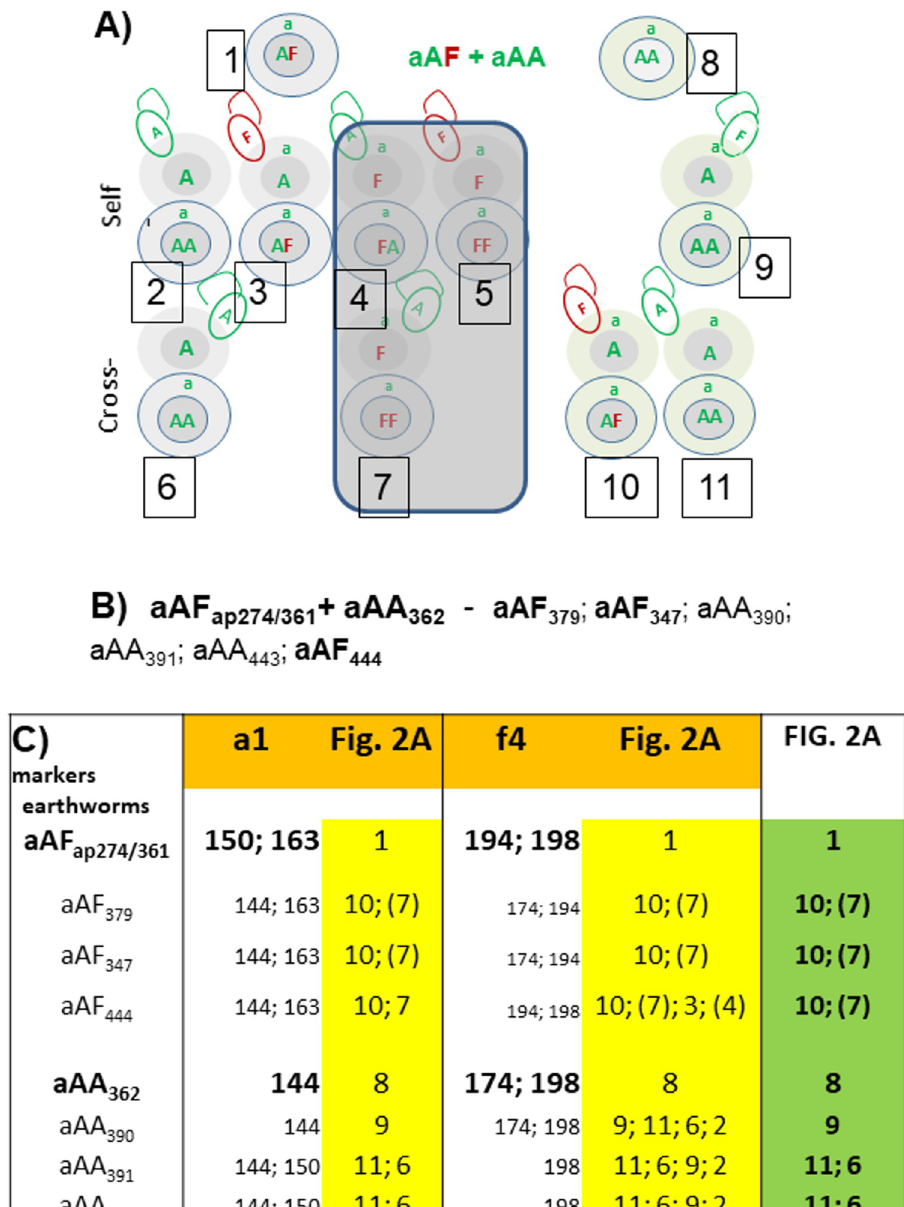
Fig 2. Considerations on the results of mating the aAF hybrid with aAA parental specimen. (A) Back-cross of aAF +aAA pair; symbols as on Fig 1. (B) Offspring of pair aAF+aAA (the example taken from [9]. (C) Allele sizes of a1 and f4 microsatellite markers in particular specimens from the above family and putative identification with genotypes 1–11 in Fig 2A (in yellow for particular markers and in green as most probable). hybrid-derived spermatozoa is indicative of gene transfer from Ef to Ea. This might be exem- plified by hypothetically polymorphic genes responsible for Ef-specific striped body pigmenta- tion pattern of the ‘tiger’ fFF grandparent mated with aAA earthworm, through the aAF parents (1) to some Ef-like earthworms (11) with mixed pigmentation pattern but genotyped as aAA by species-specific sequences of COI/28S genes [7, 8]